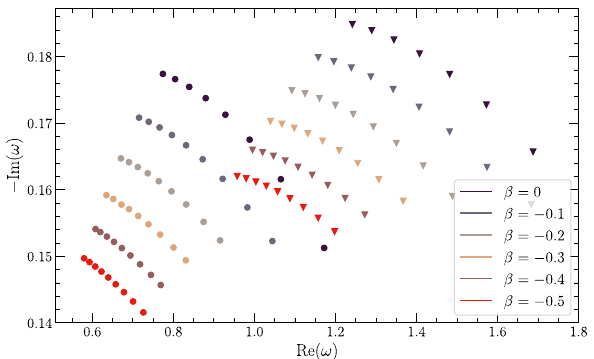
Fig. 1 In this figure we have plotted the real and imaginary parts of the QNM frequency ω n (cid:3) m for different choices of the tidal charge β . The circled points are for the fundamental (cid:3) = 2 = m mode, while the triangle-like points are for the excited (cid:3) = 3 = m mode. For each value of β , the points refer to the spin parameter having values, χ = 0 . 1 , 0 . 2 , 0 . 3 ,... 0 . 9 (left to right). As evident, with the increase of | β | , the decrease in ( Re ω n (cid:3) m ) is smaller than the decrease in ( Im ω n (cid:3) m ) . See text for more